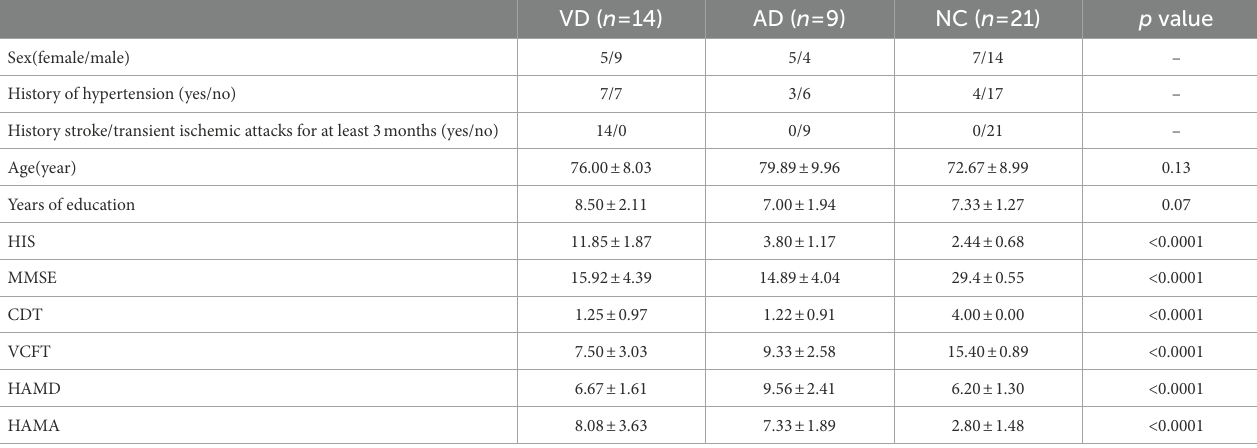
TABLE 1 Demographic and clinical characteristics of subjects and numbers of sample for NC, VD, AD